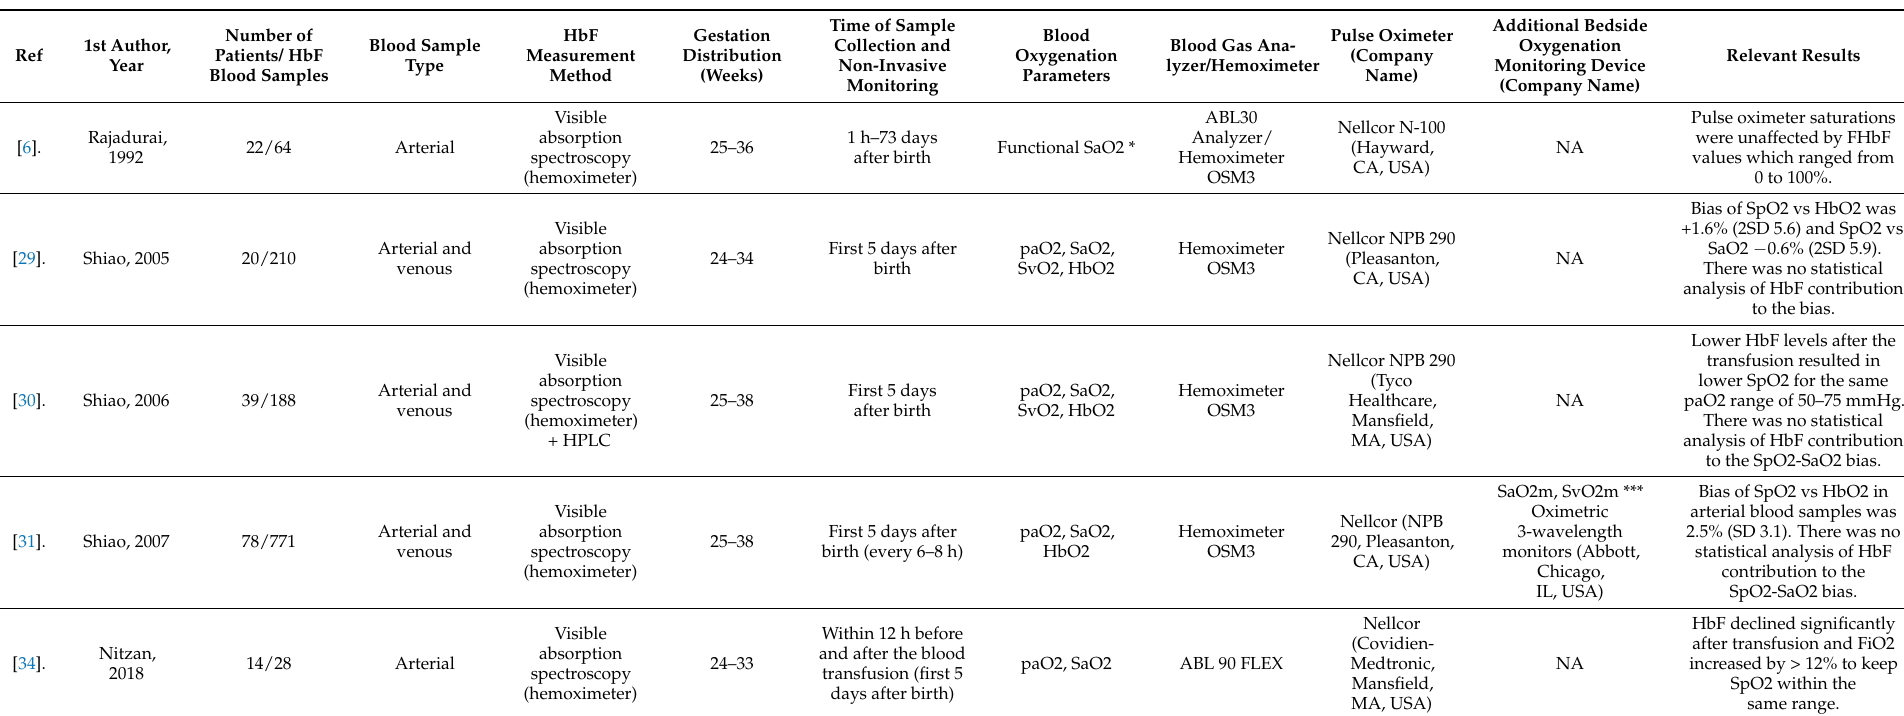
Table 2. Hemoximetry studies (after 1992) comparing SpO2 monitoring to invasively measured blood oxygenation